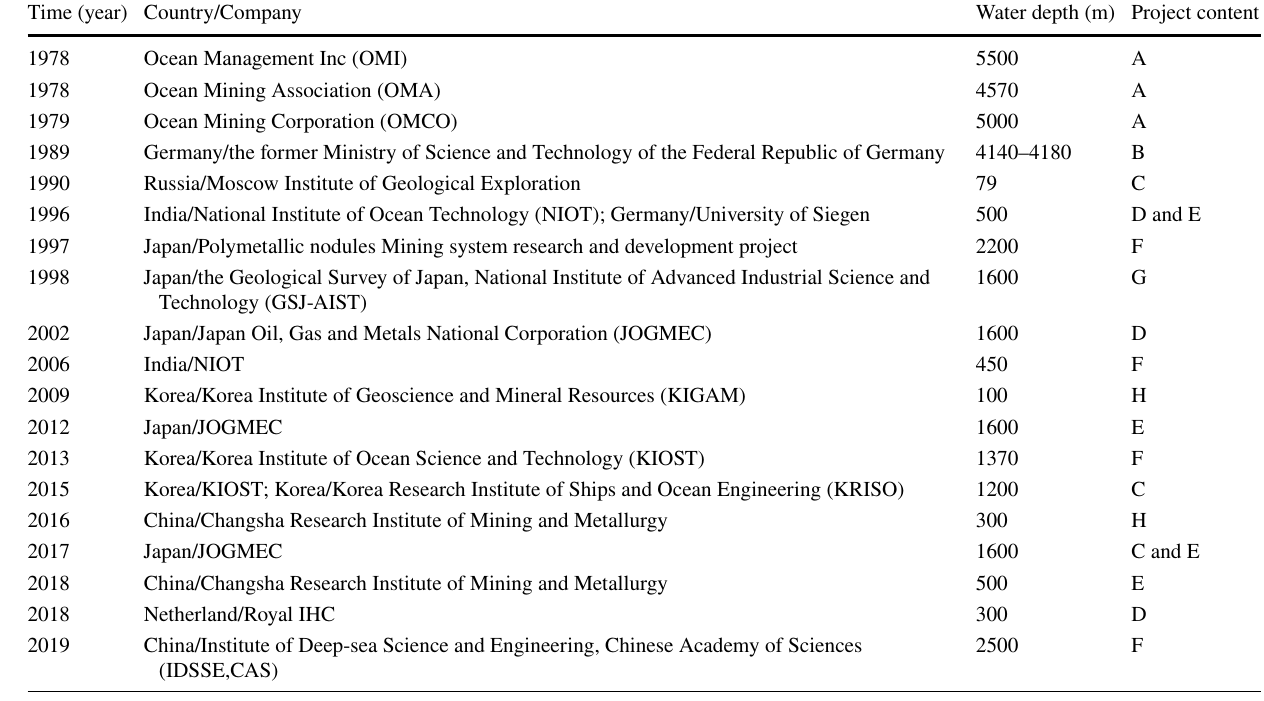
Table 1 Mining trials of deep seabed minerals and tests of some mining systems (modified from Thiel and Schriever 1990; Ding et al.